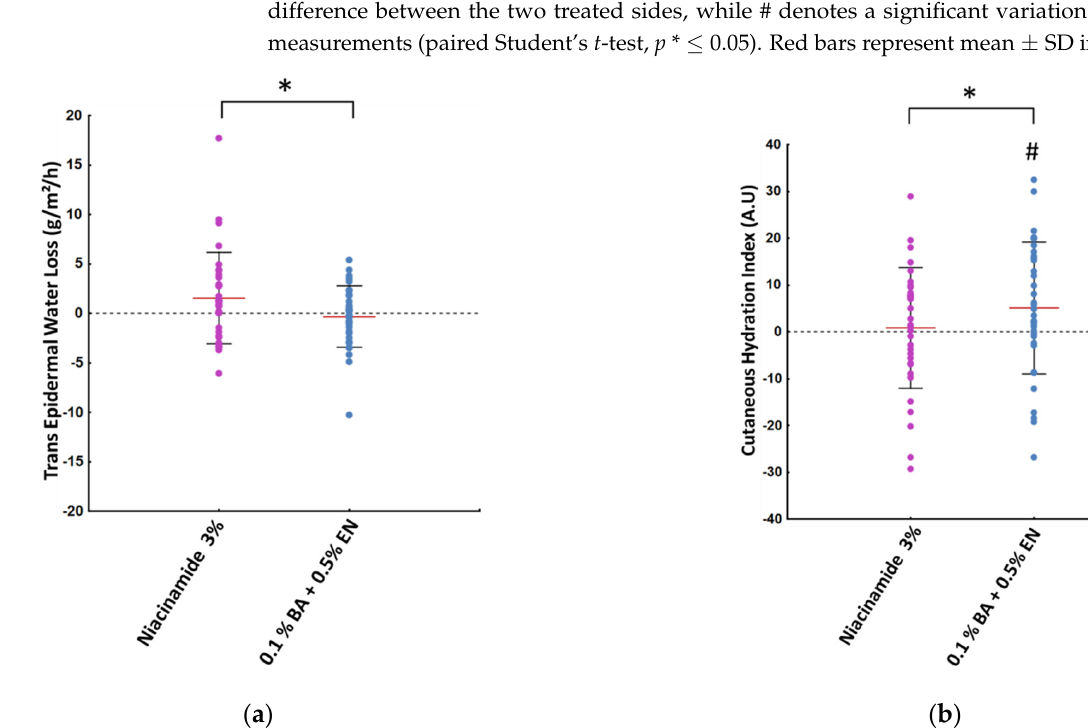
Figure 6. Trans-epidermal water loss ( a ) and cutaneous hydration index ( b ) after 28 days of treatment for the niacinamide (purple) and the BA + EN (dark blue) treated sides. * denotes a significant difference between the two treated sides, while # denotes a significant variation versus baseline measurements (paired Student’s t -test, p * ≤ 0.05). Red bars represent mean ± SD in black ( n = 36).